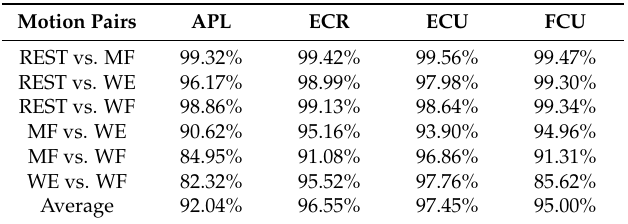
Table 5. Classification accuracy of each channel for different pairs of movements.